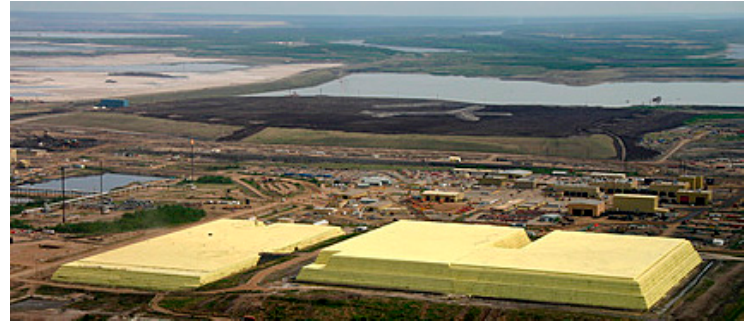
Figure 1. Oil sand sulfur stacks by Syncrude, Athabasca, AB, Canada.